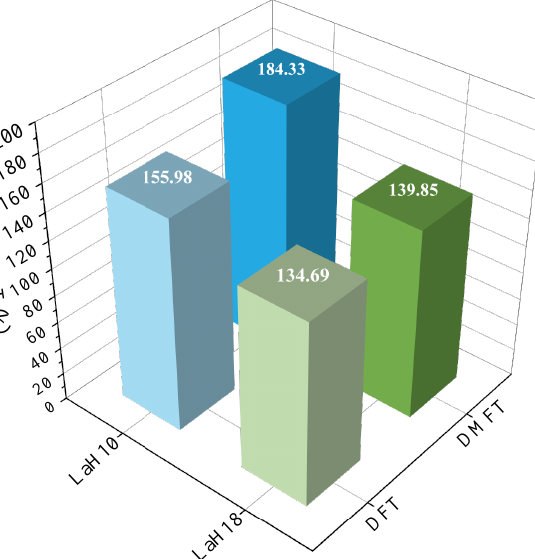
Figure 2. The superconducting temperature T c obtained by the Allen and Dynes formalism for LaH 10 and LaH 18 at 400 GPa. We obtained a theoretical estimation for LaH 10 of T c = 155.98 K by DFT and T c = 184.33 K by DMFT, and a theoretical estimation for LaH 18 of T c = 134.69 K by DFT and T c = 139.85 K by DMFT. We have used values of U = 6 eV and J = 0.6 eV. All these calculations have been carried out using Fm3m-LaH 10 and Fmmm-LaH 18 at 400 GPa.